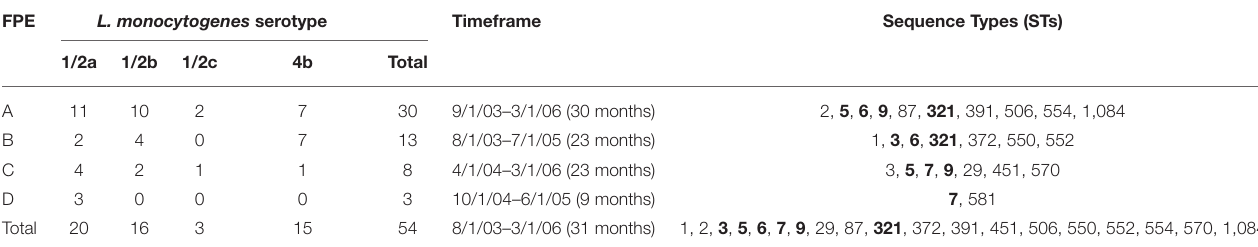
TABLE 1 | Composition of the panel of L. monocytogenes strains investigated in this study.